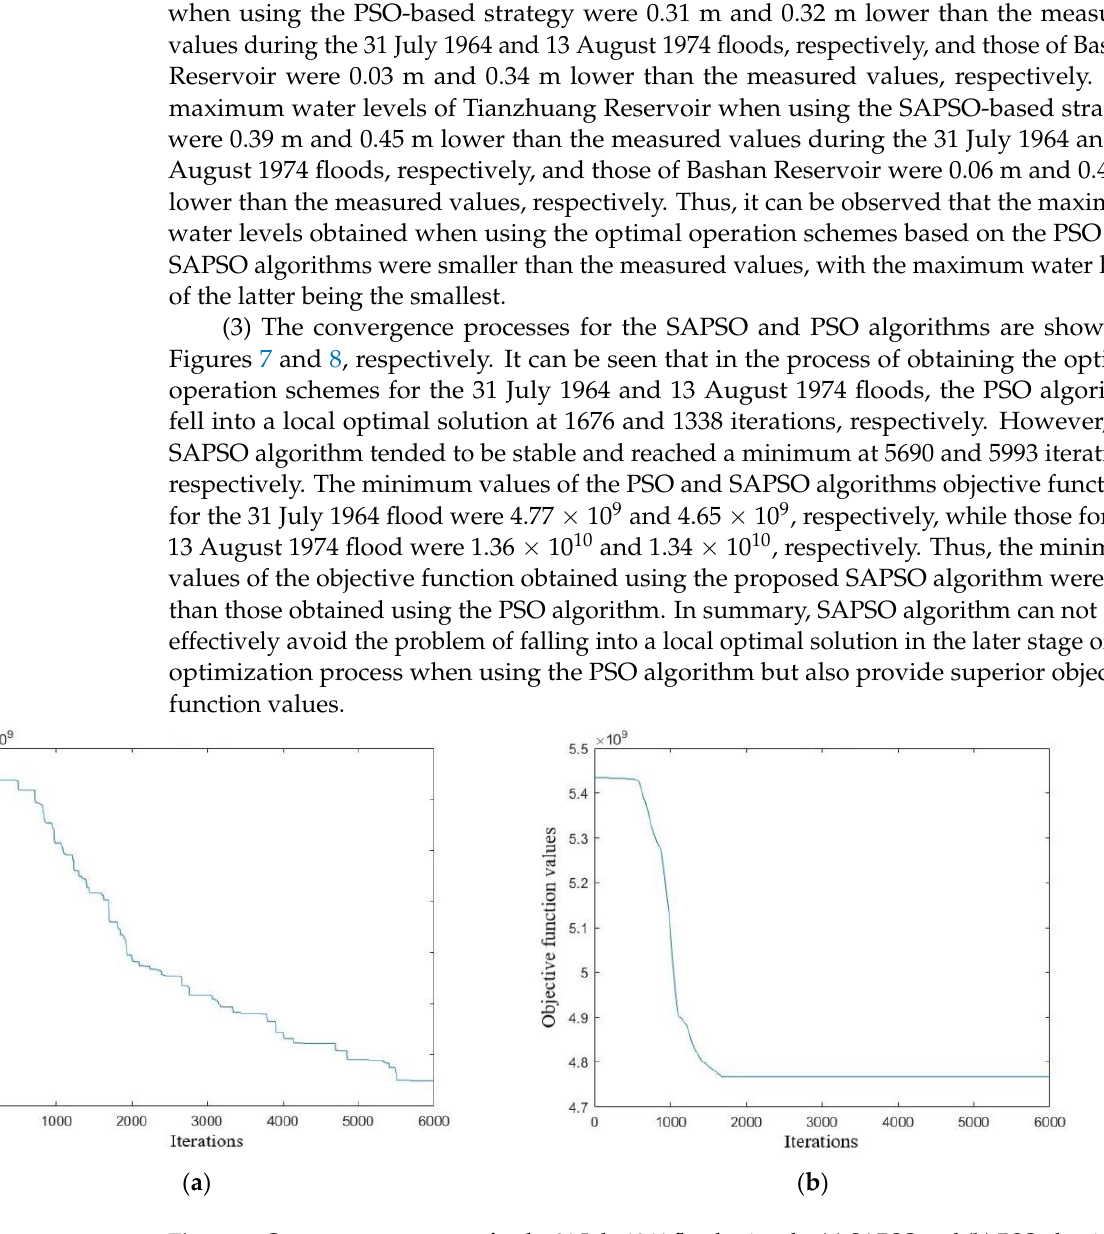
Figure 7. Convergence processes for the 31 July 1964 flood using the ( a ) SAPSO and ( b ) PSO algo- rithms.